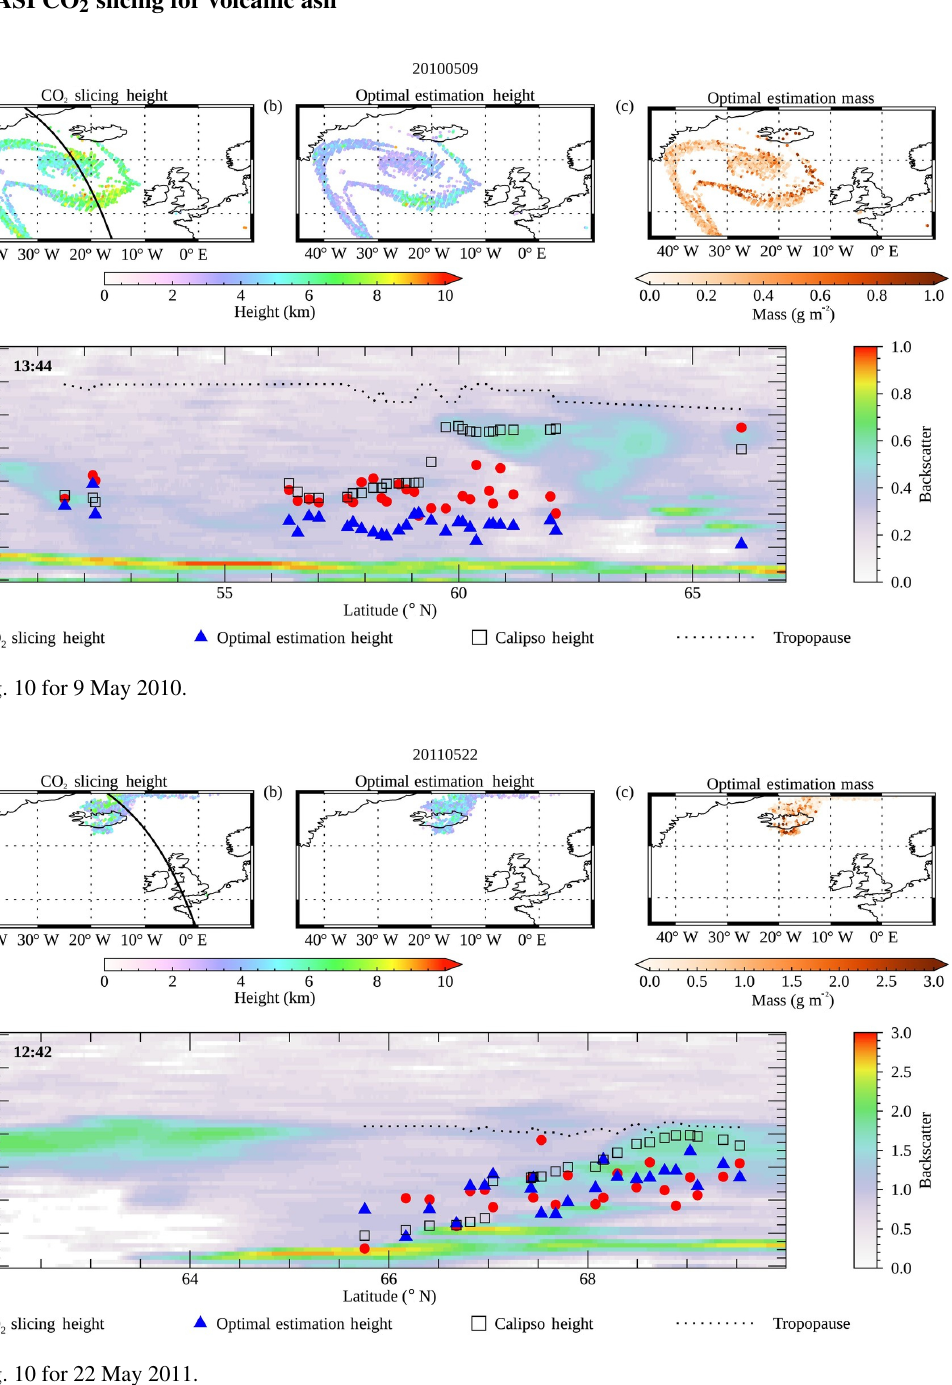
Figure 12. Same as Fig. 10 for 22 May